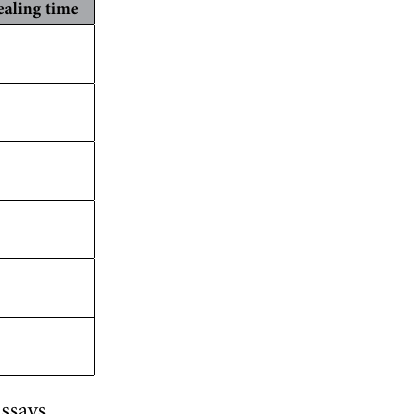
Table 2. Primers and annealing temperatures for qPCR